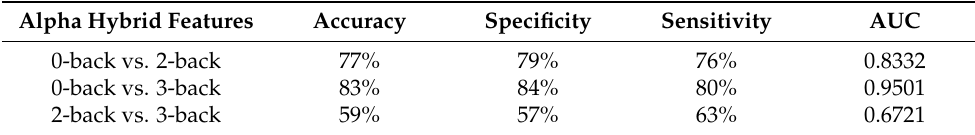
Table 5. Performance of classification for 3 binary classification